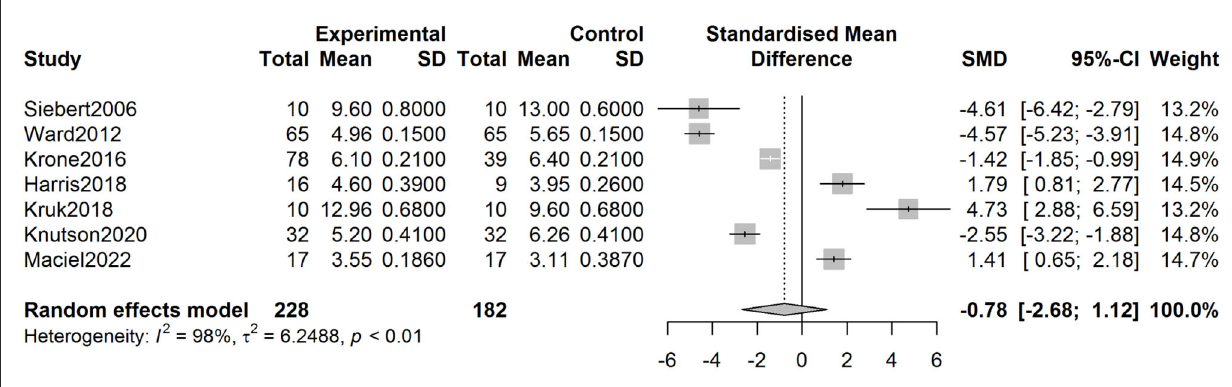
FIGURE3 Forest plots of IMF percentage in the vitamin A and control groups.